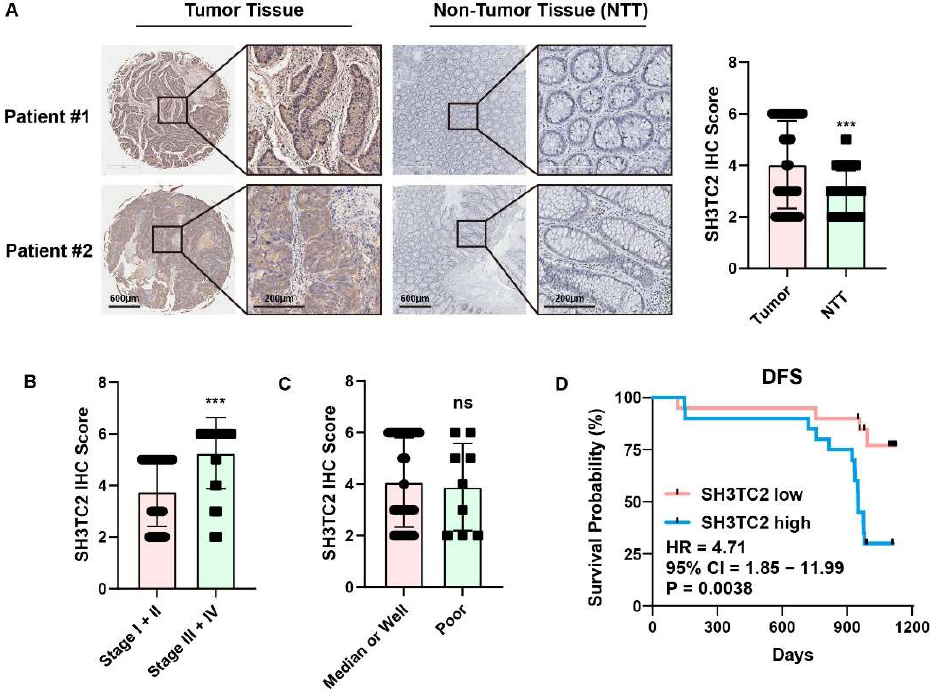
Figure 3. Overexpressed SH3TC2 indicated poor clinical prognosis. ( A ) Representative SH3TC2 IHC staining of clinical specimens. In our cohort, expression of SH3TC2 was significantly upregulated in tumor tissues compared with nontumor tissues (NTTs). ( B ) SH3TC2 is upregulated in advanced CRC patients (TNM III and IV stages). ( C ) Expression of SH3TC2 is not related to tumor differentiation. ( D ) Kaplan−Meier analysis of CRC patients with high or low expression of SH3TC2. Patients with higher SH3TC2 expression had poor DFS. Statistical analysis was compared between two groups: ns, not significant; *** p < 0.001.